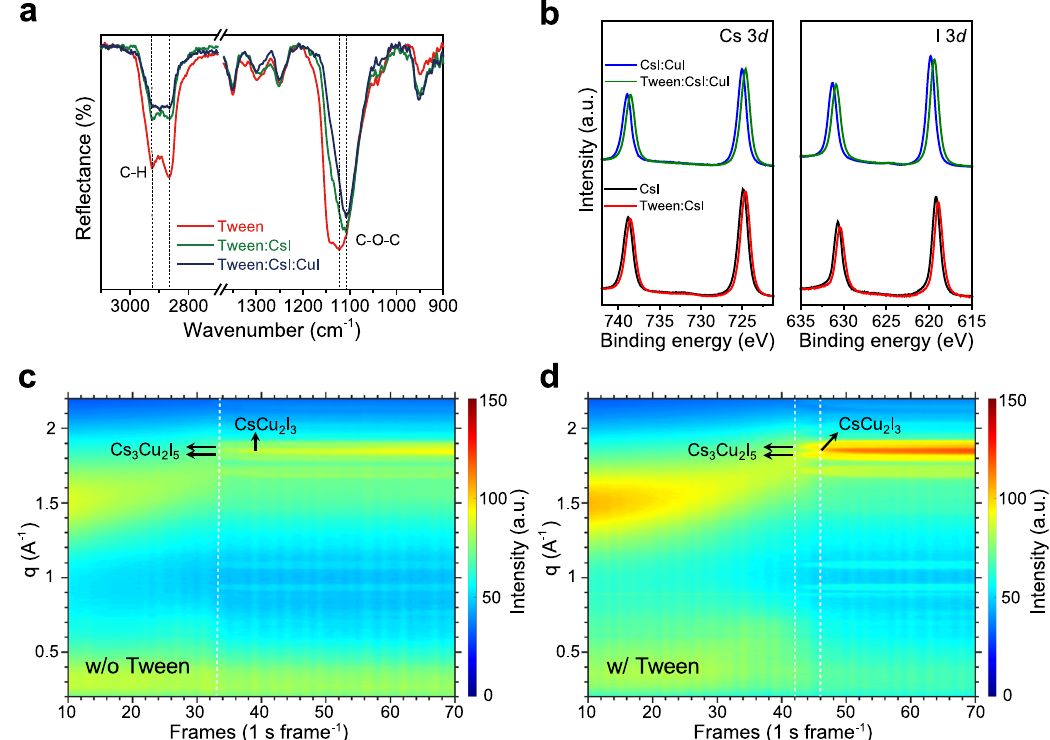
Fig. 4 Characterizations of interaction between Tween and cesium copper iodides. a FTIR spectra. The spectrum of Tween shows peaks at 2866 and 2924 cm − 1 ascribed to the C – H stretching vibrations, and a peak at 1122 cm − 1 ascribed to C – O – C stretching vibration. After adding Tween to CsI, the relative intensity of 2866 and 2924 cm − 1 peaks changes, and the 1122 cm − 1 peak shifts to 1107 cm − 1 . b XPS spectra of CsI, Tween:CsI, CsI:CuI, and Tween: CsI:CuI fi lms. After adding Tween to CsI, the Cs 3 d and I 3 d peaks of CsI shift to the lower binding energy. c , d Time-resolved GIWAXS pro fi les of samples without ( c ) and with ( d ) Tween. The sample without Tween simultaneously forms CsCu 2 I 3 at | q | = 1.84 Å − 1 and Cs 3 Cu 2 I 5 at | q | = 0.93, 1.08, 1.71, 1.82, and 1.88 Å − 1 (around 33 s). After the inclusion of Tween, the CsCu 2 I 3 appears at 46 s, which is 4 s later than the Cs 3 Cu 2 I 5 . NATURE COMMUNICATIONS| (2021) 12:1421